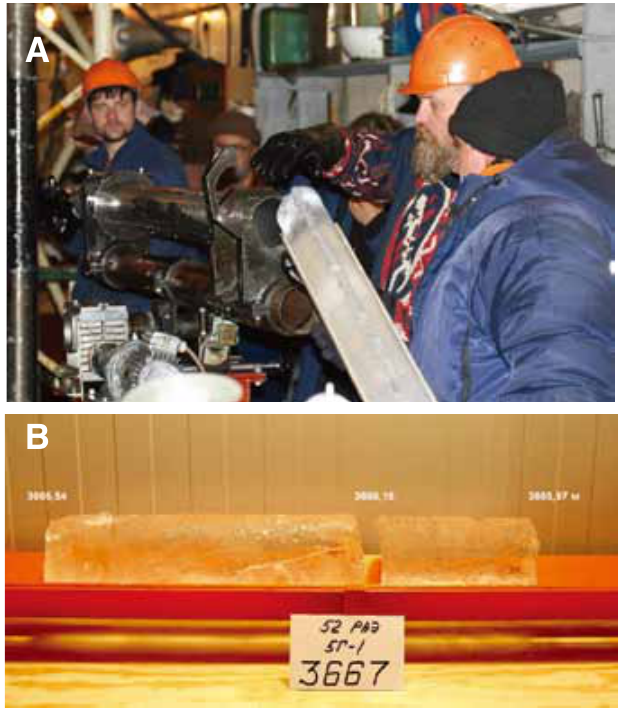
Figure 4. [A] Core recovering from the core barrel (January 2007). [B] Ice core from the deepest